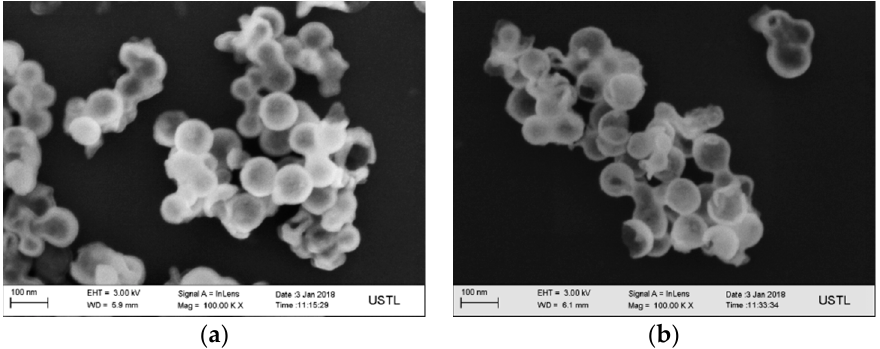
Figure 5. SEM images of the sample calcined in an air atmosphere at 550 °C (×100,000) ( a ): SEM images of intact magnesia hollow sphere ( b ): SEM images of cracked magnesia hollow sphere.